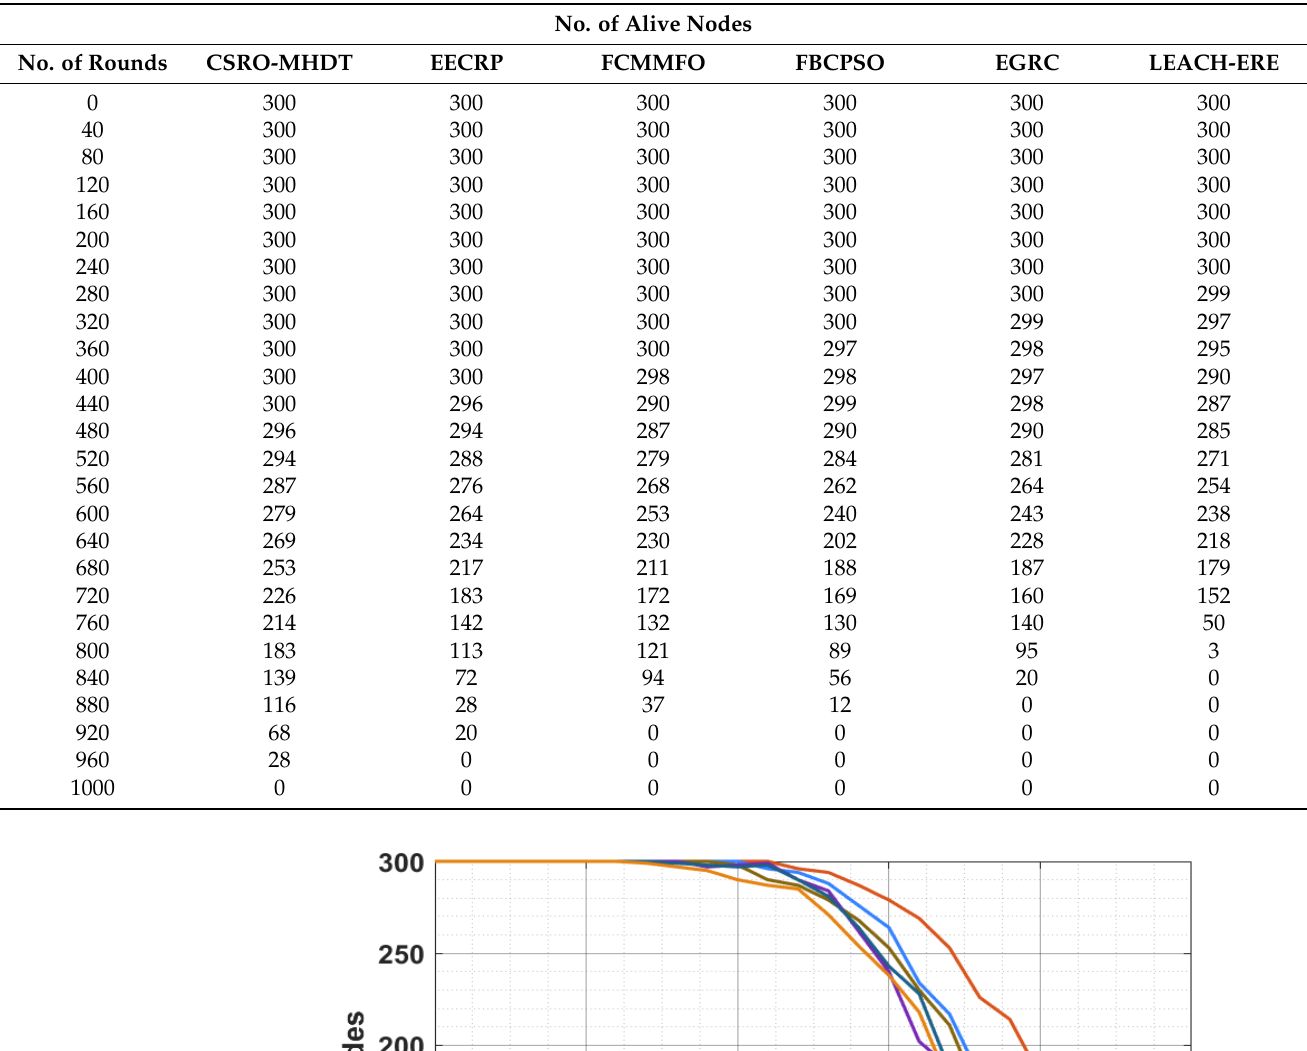
Table 2. NAN study of the CSRO-MHDT technique in comparison with existing methods analyzed under different rounds.